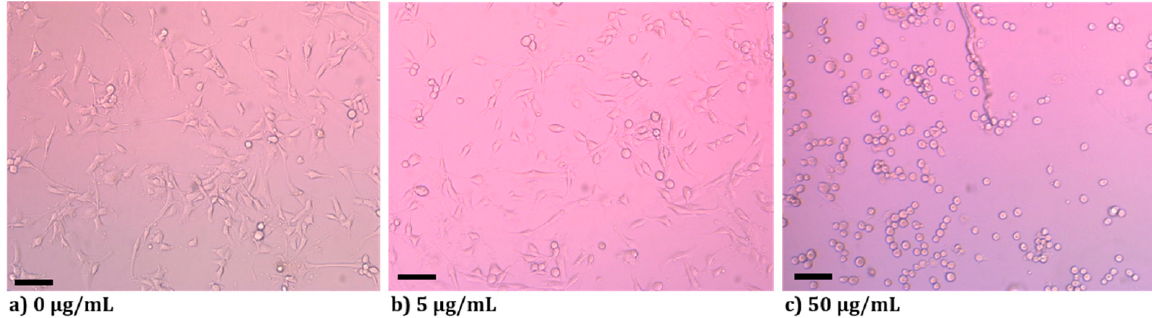
Figure 8. Optical images of cells 24 h post irradiation with 808 nm laser for 10 min ( P = 3 W/cm 2 ) after 24 h-incubation with AuAgNTrs with concentration ( a ) 0, ( b ) 5 and ( c ) 50 μ g AuAg/mL. Scale bar 100 μ m.